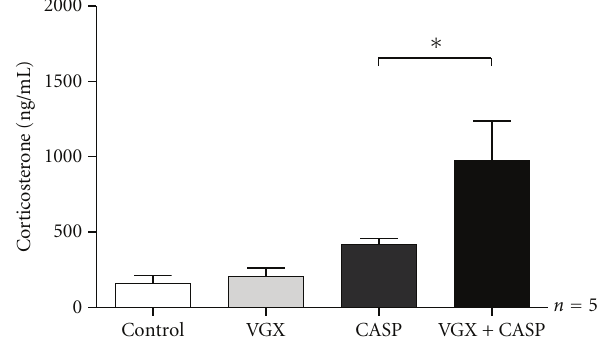
Figure 5: The serum levels of corticosterone in sepsis are modulated by the vagus nerve. Vagotomy in the nonseptic organism does not influence the corticosterone level (205 . 9 ± 56 . 75 ng/mL). In polymicrobial sepsis, serum corticosterone is detected with 159 . 4 ± 53 . 24 ng/mL. In contrast, 24 h following CASP in vagotomised mice the corticosterone level is significantly increased up to 975 . 4 ± 261 . 9 ng/mL ( ∗ P = 0 . 031, Mann-Whitney, n =